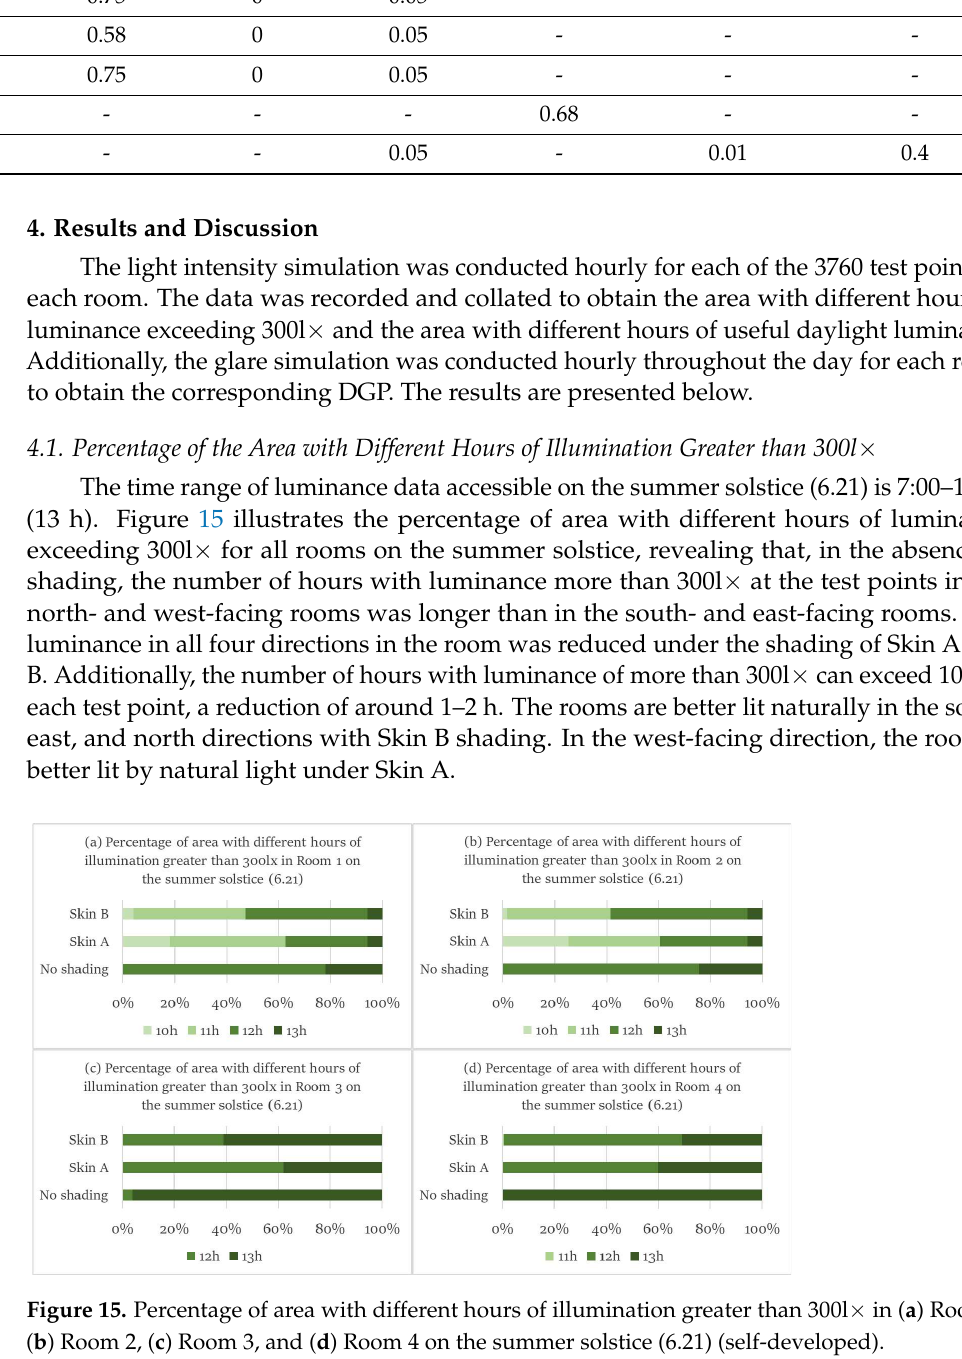
Figure 16. Percentage of the area with different hours of illumination greater than 300l× in ( a ) Room 1, ( b ) Room 2, ( c ) Room 3, and ( d ) Room 4 on the winter solstice (12.21) (self-developed).